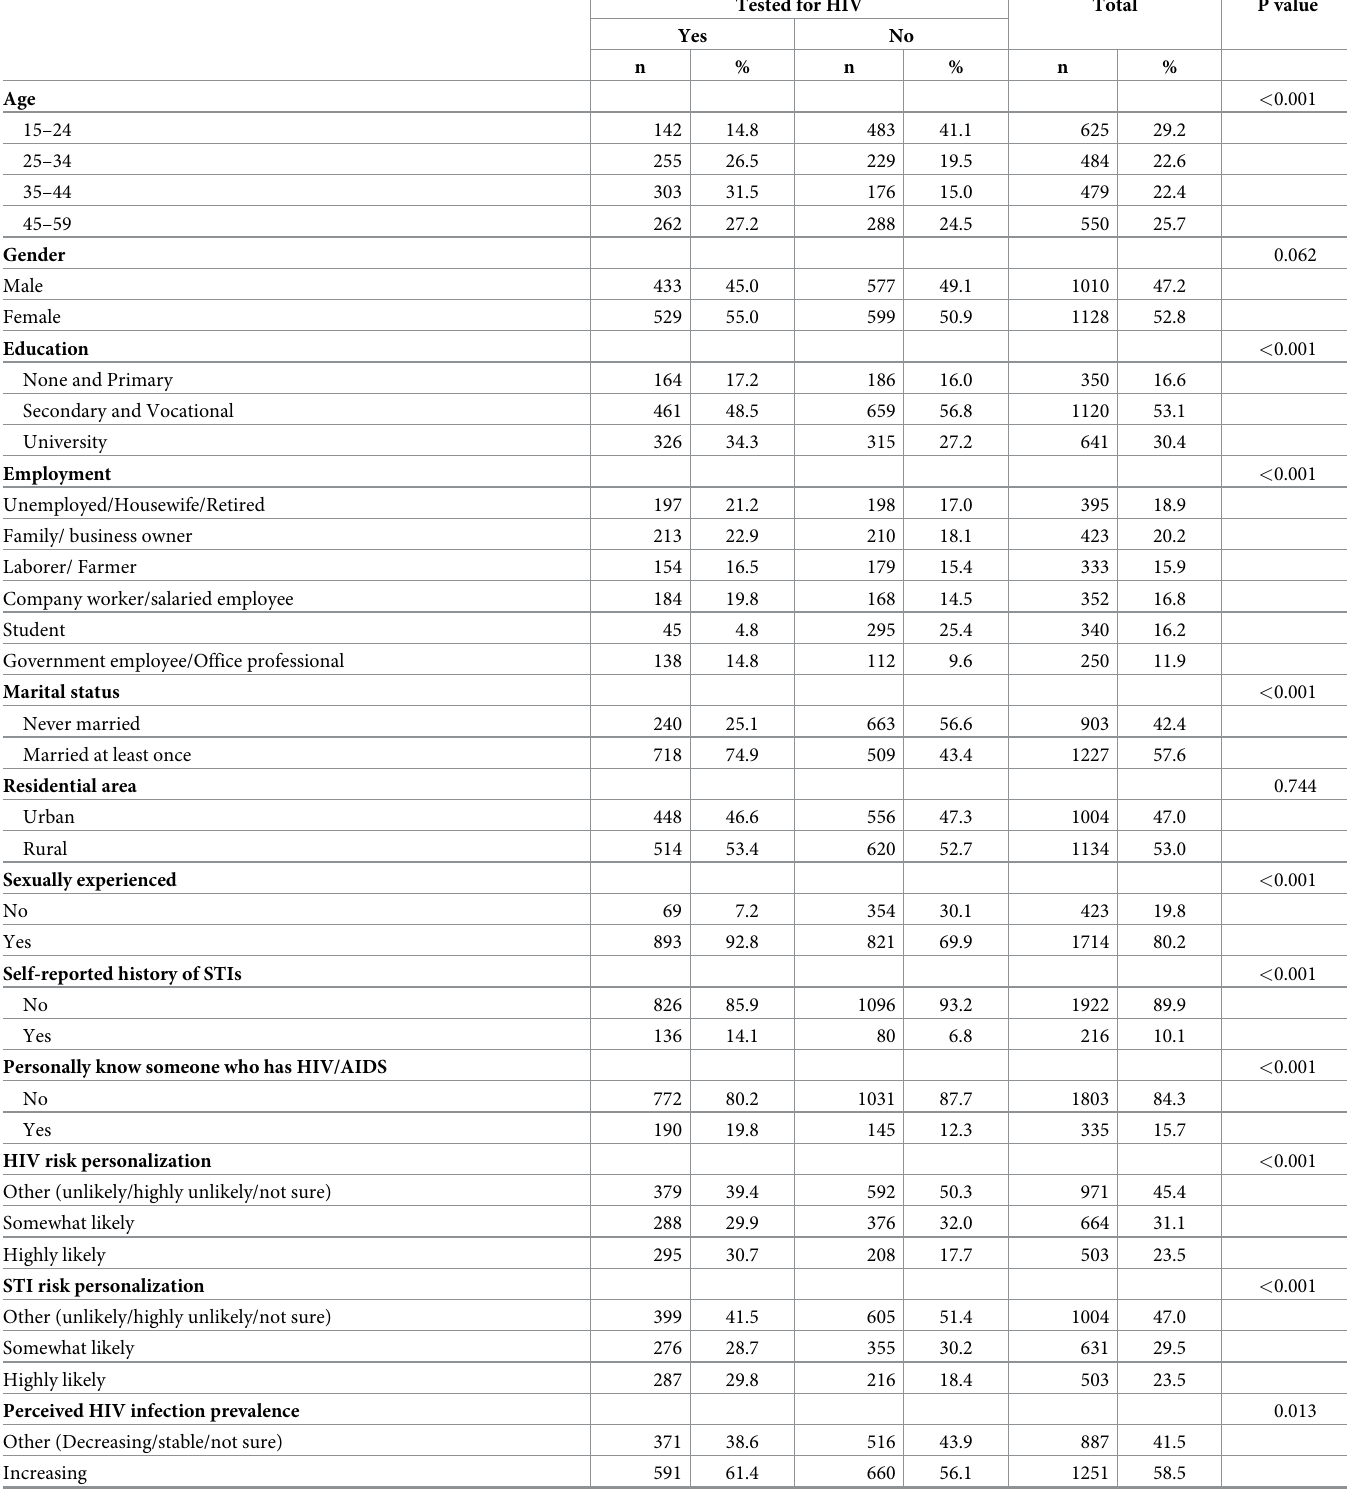
Tested for HIV Total P